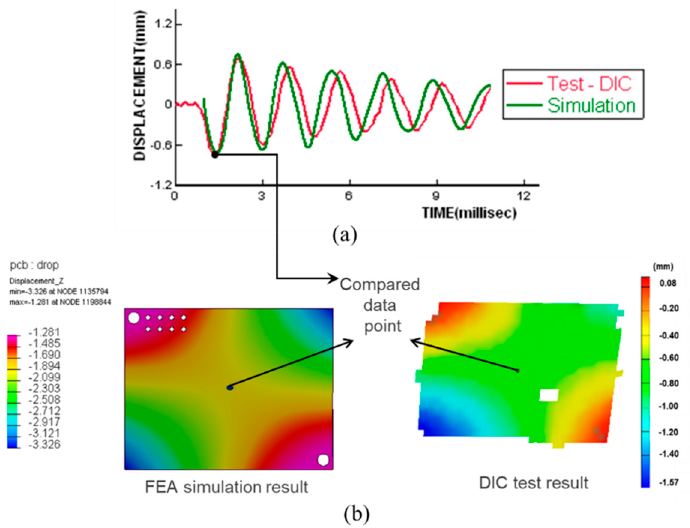
Figure 12. Drop response of the bare PCB (0.8 mm thickness) with fixture I: ( a ) Displacement with respect to time, ( b ) out-of-plane deformation contour plot for FEA and DIC test results.